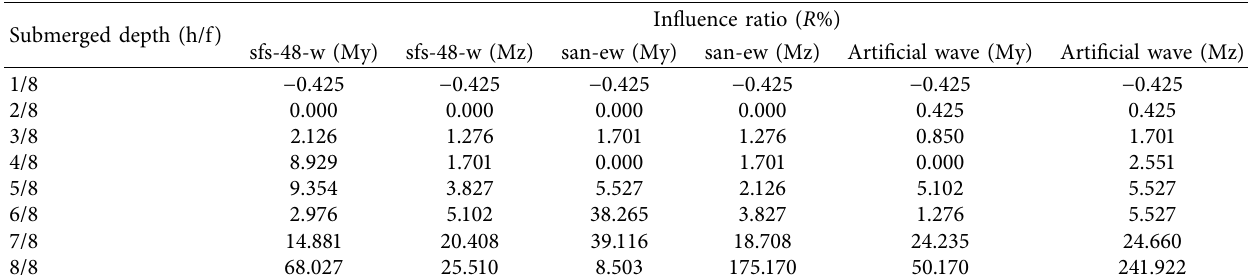
Table 8: Te relation of R and submerged depth at 6L/16 of the